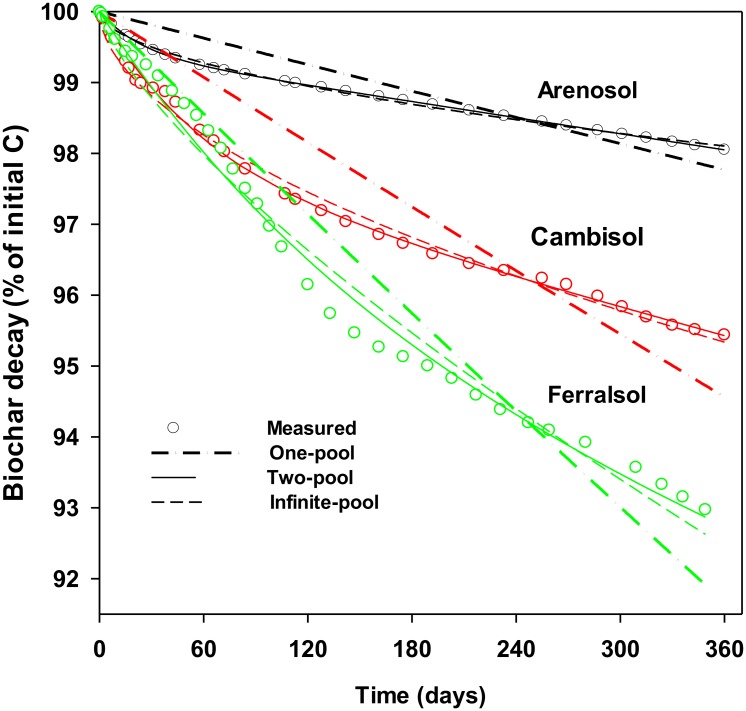
Percent of biochar-C decayed in Arenosol (black), Cambisol (red) and Ferralsol (green) over 12 months.The three models employed to estimate mean residence time of biochar-C in soil were (i) one-pool exponential (dotted line), (ii) two-pool exponential (solid line) and (iii) infinite-pool power model (dash line).